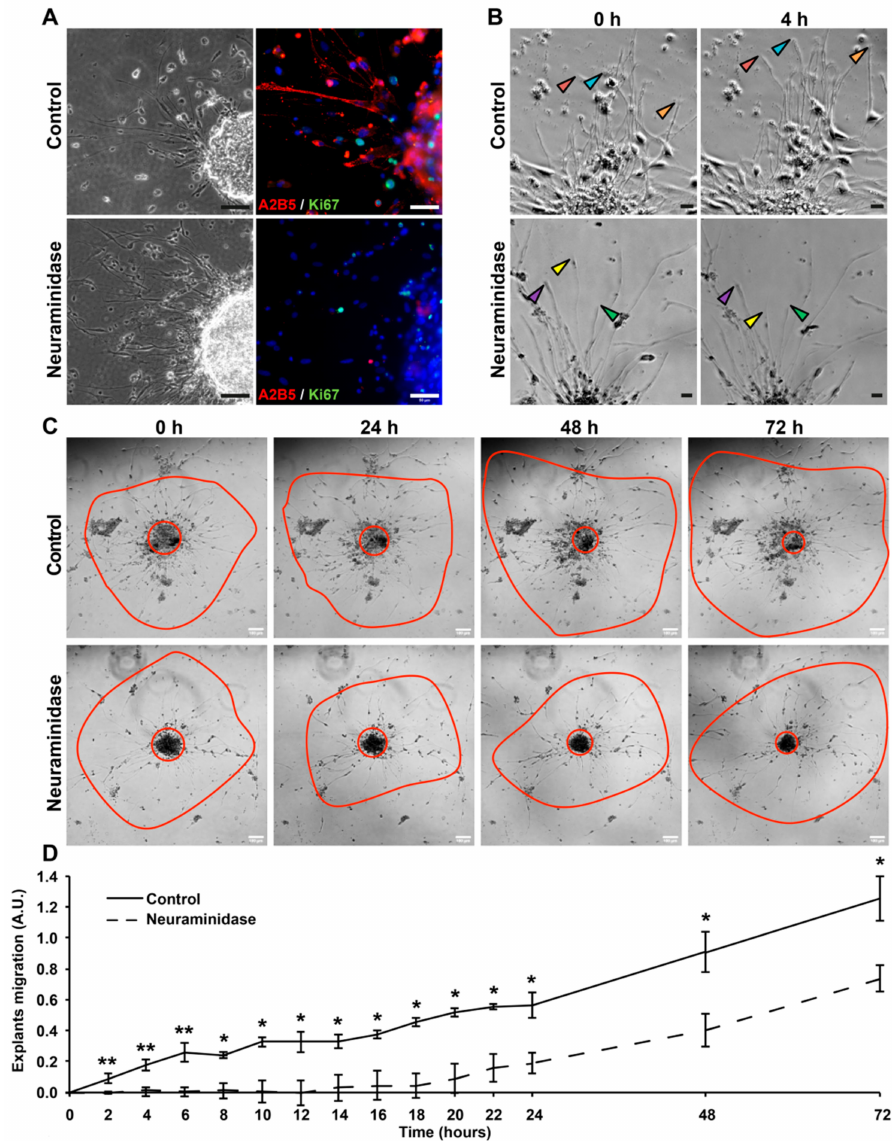
Figure 5. Neuraminidase a ff ects the migration of human GBM explants. ( A ) Phase-contrast images and immunofluorescent double-staining of A2B5 (in red) and Ki67 (in green) of control and 72 h treated (1 U / mL neuraminidase) explants. Cell nuclei are counterstained in blue. Scale bar = 50 µ m. ( B ) Using time-lapse video microscopy at regular intervals, cells migrating radially from explants in basic conditions or with 1 U / mL neuraminidase were accurately observed for 72 h. Arrows allow us to follow the migration of some cells. Scale bar = 50 µ m. ( C ) Representative phase contrast images taken over time of control and treated (1 U / mL neuraminidase) explants. For each explant, the central red circle allows us to visualize the explant’s core, while the outer red line shows the cell migration area. Scale bar = 100 µ m. ( D ) The distance of migrating cells from the explant’s core was quantified in basic conditions or with 1 U / mL neuraminidase ( n = 3 experiments). Non-parametric Wilcoxon–Mann–Whitney test shows * p < 0.05 and ** p < 0.01. ns: